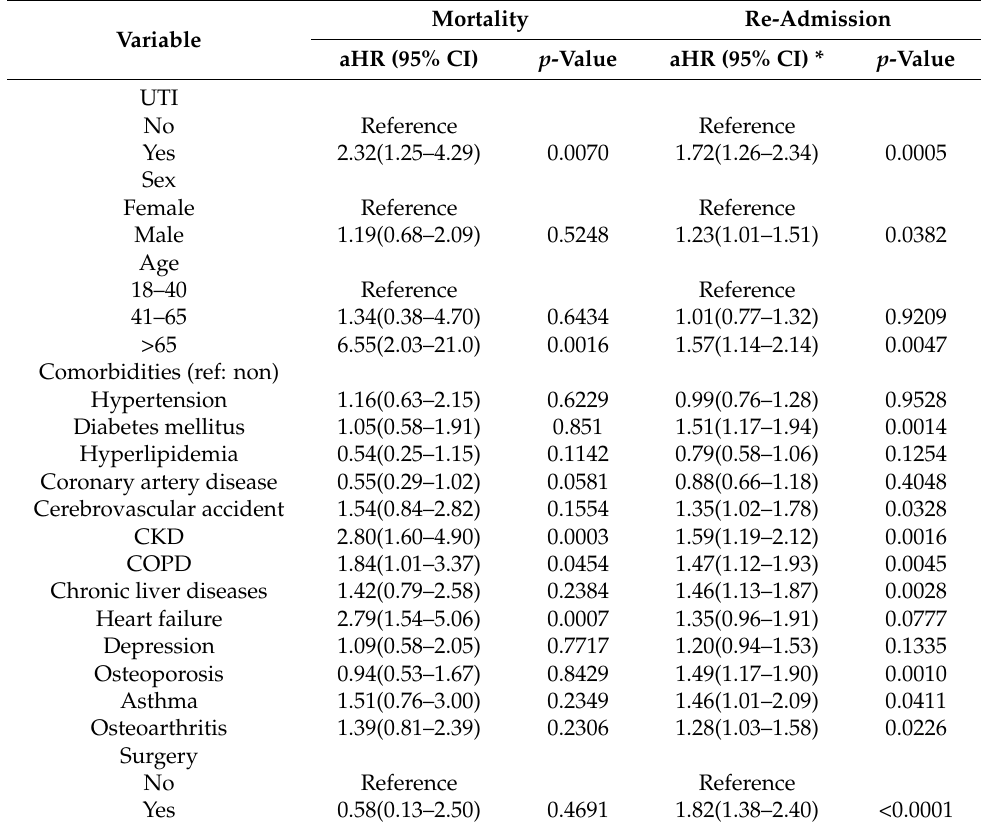
Table 3. Multiple Cox regression to estimate the hazard ratio for the mortality risk and